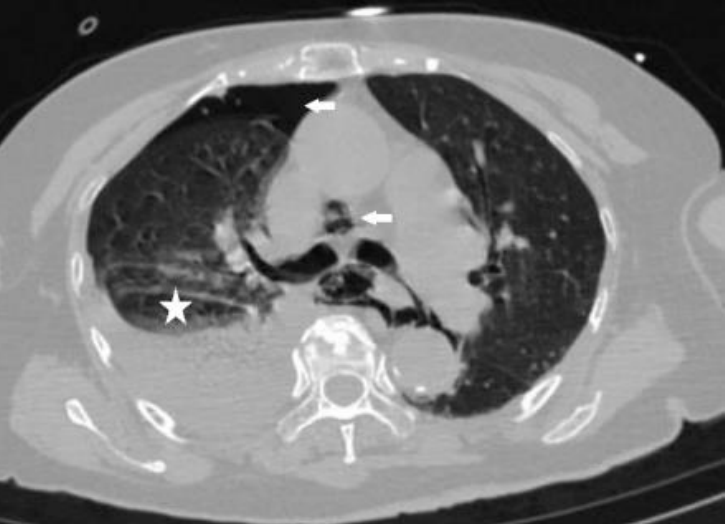
Figure 1. Computed tomography (CT) of the chest shows the gas in the right thoracic cavity and mediastinum (arrows) and right pleural effusion (star).